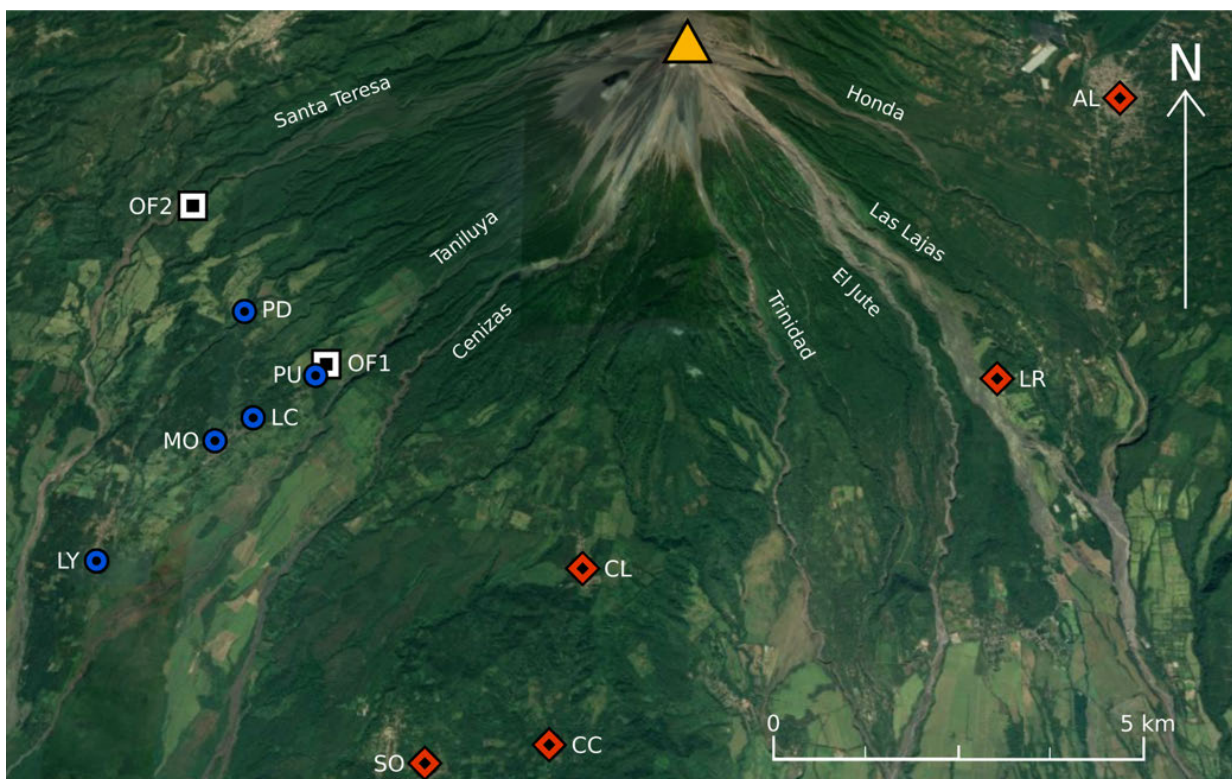
Figure 2: Map of locations visited at Fuego in 2019. Blue circles represent communities on west flanks: LC (La Colonia), LY (Los Yucales), MO (Morelia), PD (Panimaché Dos), PU (Panimaché Uno). Red diamonds represent communities further east: AL (Alotenango), CC (Chu-chu), CL (Ceilán), LR (La Reunión), SO (San Andrés Os- una). White squares represent INSIVUMEH observatories: OF1 (Panimaché Uno) and OF2 (Sangre de Cristo, permanently evacuated since June 2018). Large yellow triangle represents summit of Fuego (3763 m). Barrancas are labelled. Map data: Google Earth